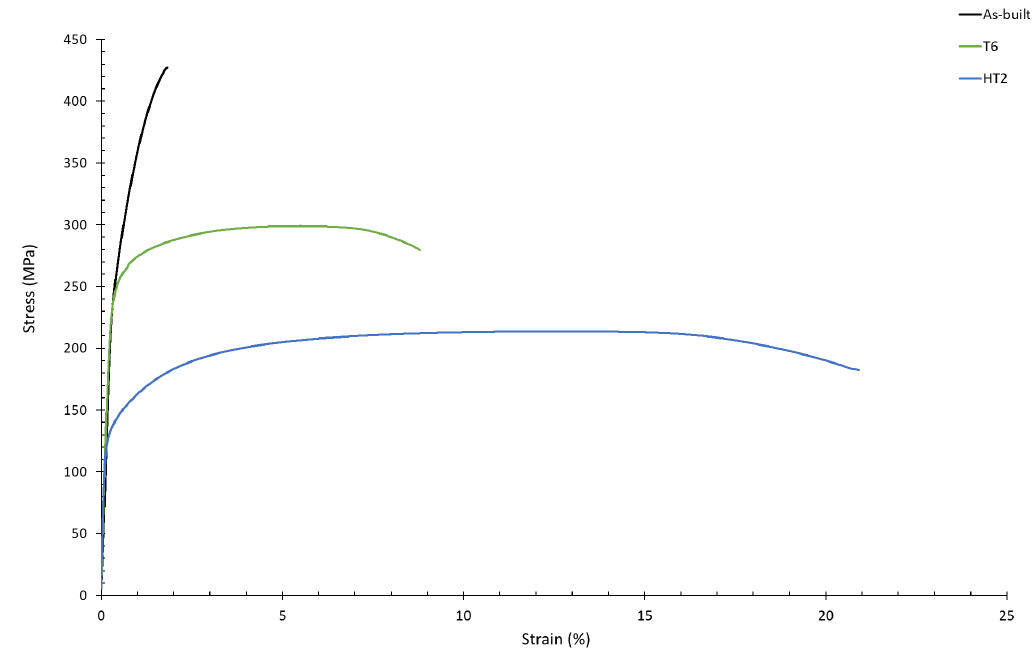
Figure 6. Tensile stress–strain diagramm for as-built, T6 and HT2. As-built LPBF condition showed the lowest strain, HT2 showed the highest tensile strain.